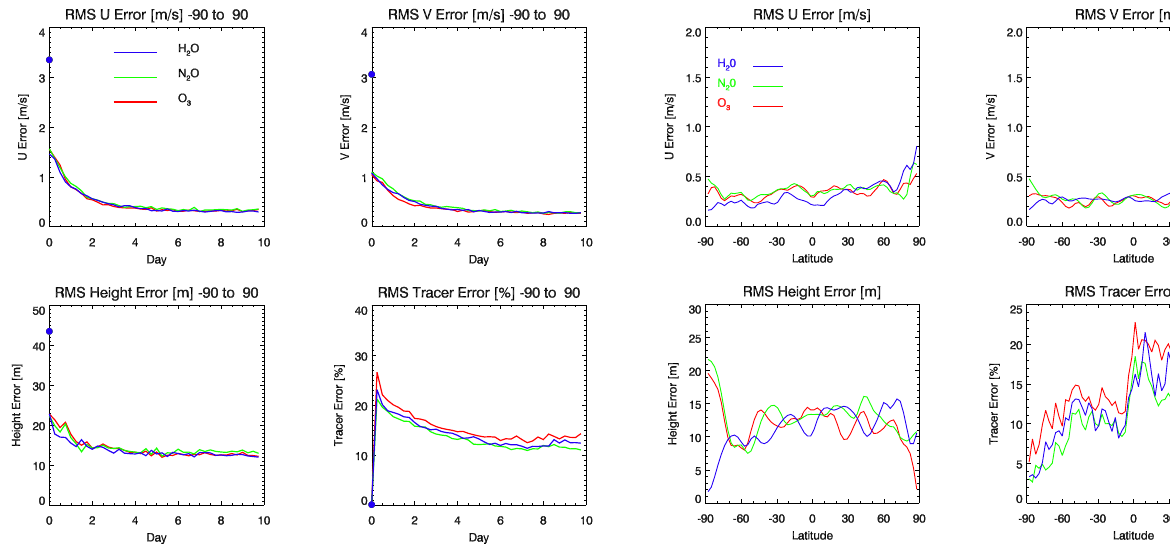
Fig. 5. Global RMSE for zonal wind, meridional wind, height, and tracer for the BEST experiment: O 3 (red), N 2 O (green), and H 2 O (blue). Units are ms − 1 for zonal and meridional wind, m for height, and tracer % relative to σ ob . Circles indicate the initial global RMSE.